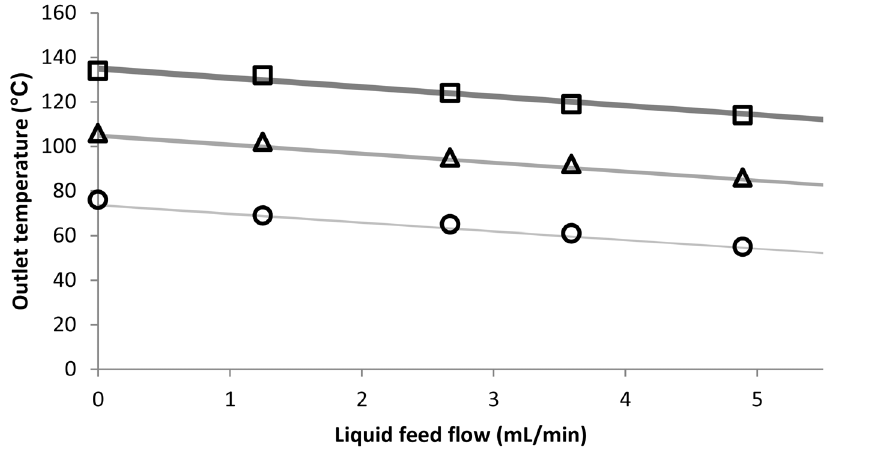
Figure 4. Modeled (grey) and experimental (black) outlet temperature. Inlet temperature was set at 100 u C (circle), 150 u C (triangle), or 200 u C (square). Aspirator flow was kept constant at 22 m 3 n /hr. Thickness of the lines indicate the 95% confidence interval of the modeled outlet temperature.